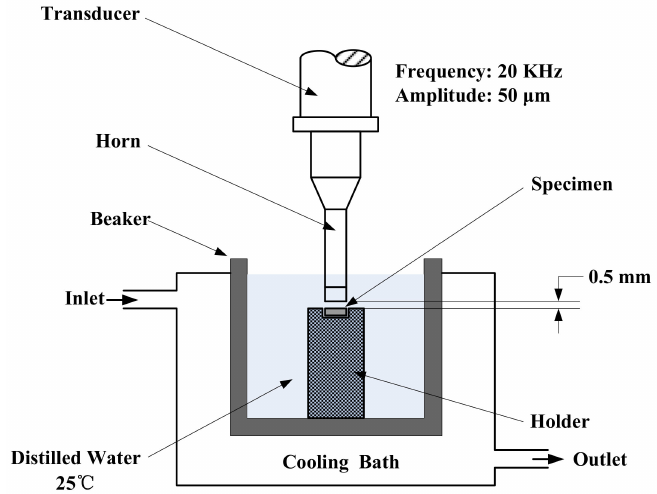
Figure 2. Schematic of the cavitation erosion test